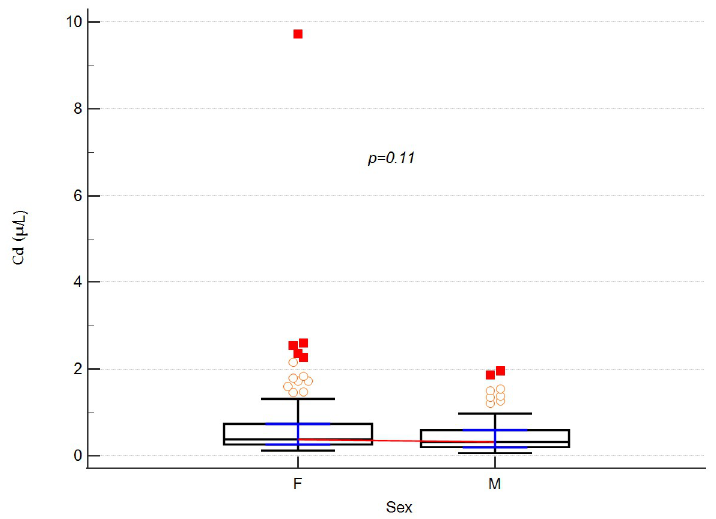
Figure 2. Cadmium levels with regard to sex. Medians and IQRs are shown. Empty dots represent individual data. Red squares are outliers.